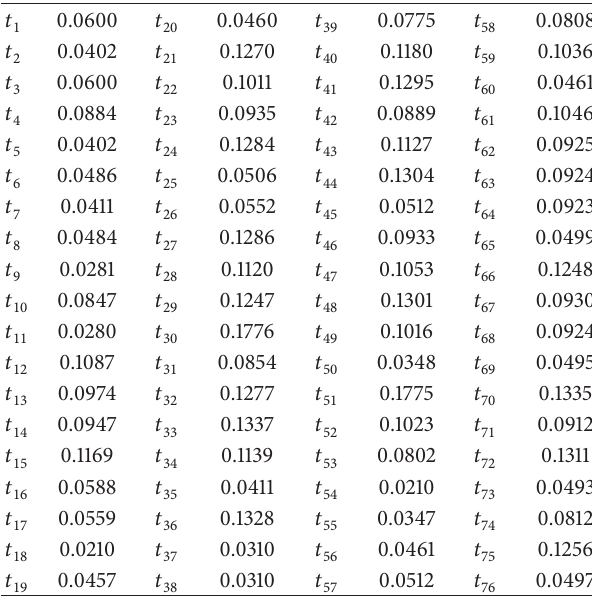
Table 10: The resulting link travel times from solving Sioux Falls network.